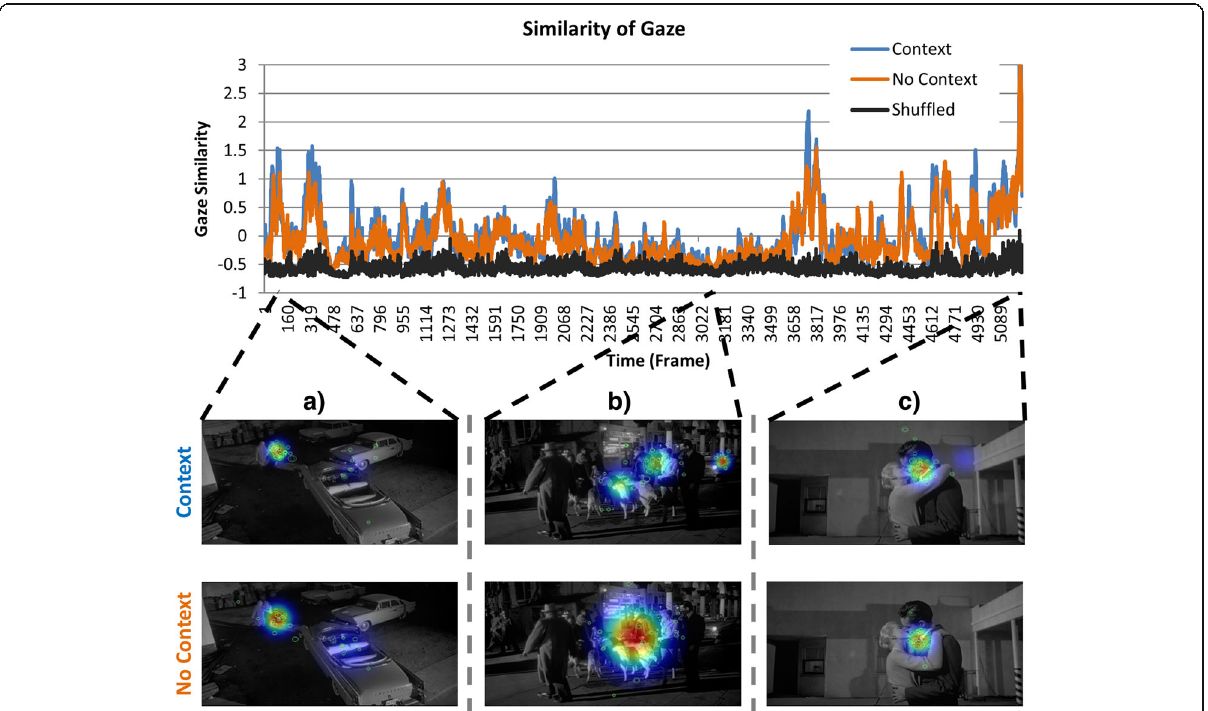
Fig. 2 Top : Similarity of gaze by context condition across the shared viewing period of the clip. Gaze similarity is expressed as a z-score probability relative to the Context condition. (Context [ blue ], No-context [ orange ], and shuffled baseline [ black ]). Large values indicate greater gaze similarity. Bottom : Three of the peaks in gaze similarity are illustrated by image frames with superimposed heat maps of participant gaze location. The frames show the gaze heat maps at the points indicated on the gaze similarity figure for both the Context and No-context conditions. Frames a and c show high gaze similarity, while frame b shows low gaze similarity. Note that frame c was the single highest level of attentional synchrony in the entire film clip. Gaze heatmaps produced by CARPE (Computational and Algorithmic Representation and Processing of Eye-movements; Mital et al.,